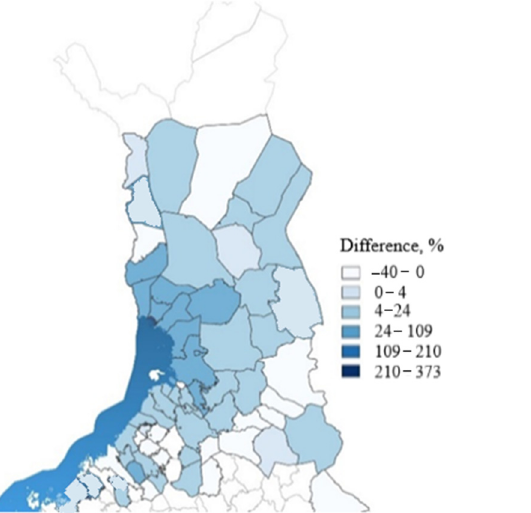
Figure 9. Percentage increase (blue color) in market shares by municipality between Scenario 2 and baseline scenario in optimized wood procurement of pine logs (left map). Increase in market share of pine logs (red color) between optimized baseline Scenario and initial experiment is described in right map.